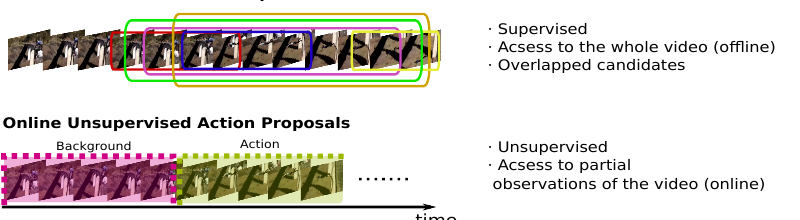
Figure 1. Comparison between the standard offline Action Proposals paradigm, and the novel online and unsupervised approach introduced in this